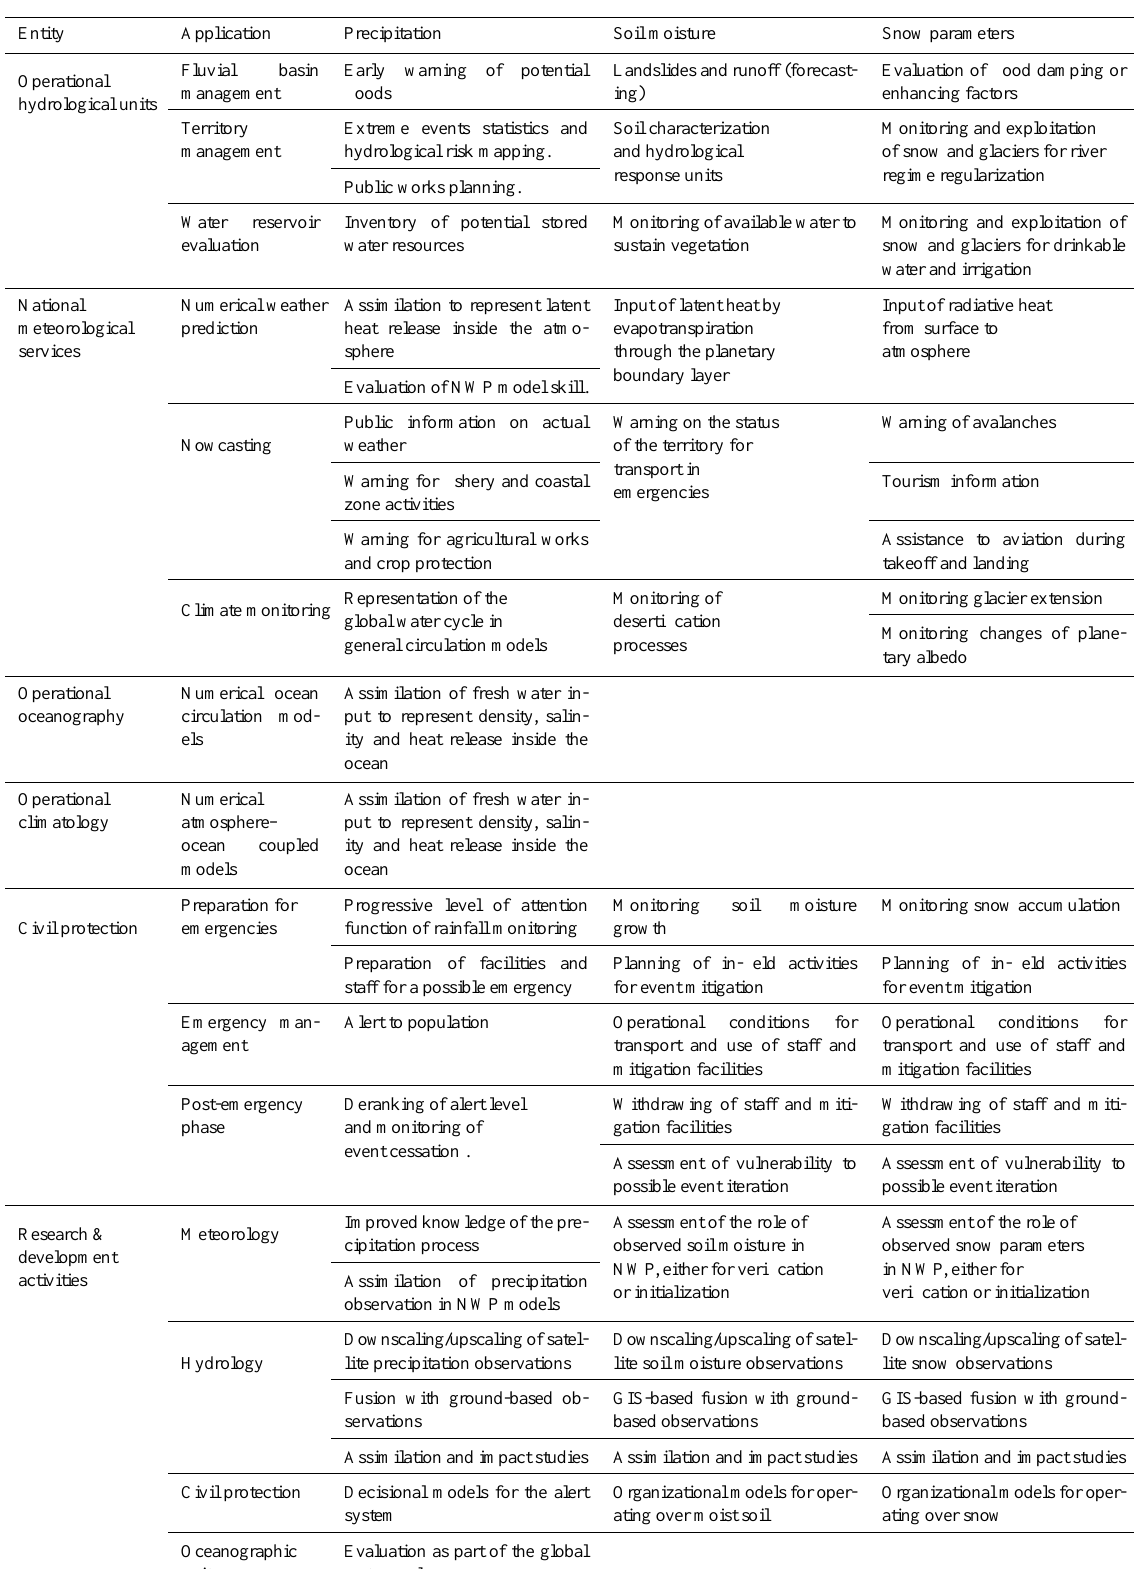
Table 2. User communities potentially addressed by